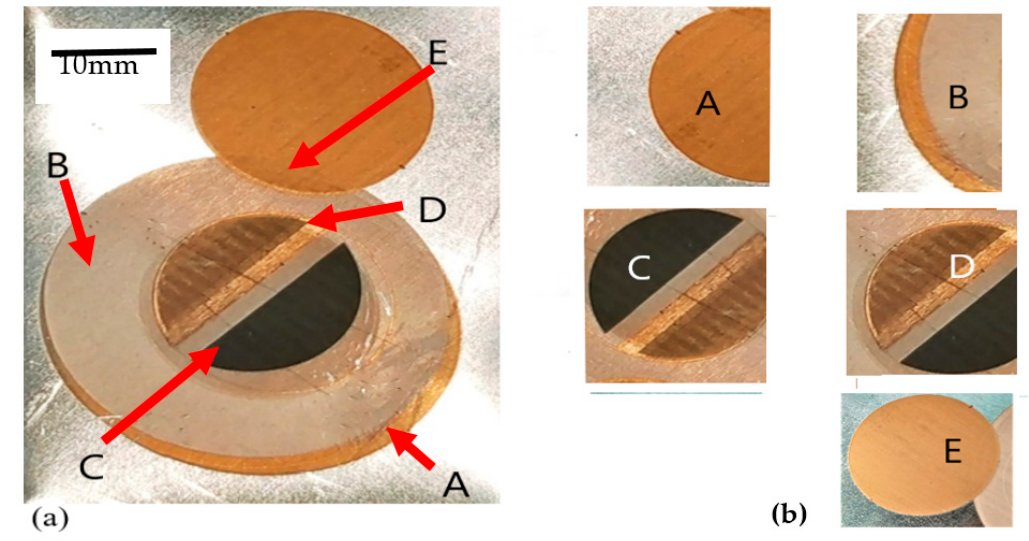
Figure 5. Demonstration of erasing the color from the treated sample and formation of new colors produced on the erased surface of aluminum. Panel ( a ): original sample; panel ( b ): explanation of panel ( a ): A , initially created dark golden disk. B , whitish color after erasing dark golden color, C , black semi-circle after erasing whitish color, D , light golden strip after erasing whitish color, and E , dark golden color painted on the whitish color. The scanning speeds for dark golden, white, black, and light golden were 70 mm / s, 1500 mm / s, 10 mm / s, 200 mm / s (two runs) respectively. The fluence of the laser beam was in the range 0.5–1.0 J / cm 2 . Figure 5b represents the images of A, B, C, D and E parts repectivly. In the center of the circle a strip was colored to light golden (D), and finally, part of the whitish surface of the same sample was colored to dark golden (E). Such manipulation of colors demonstrates the reproducibility and sustainability of these samples. The erasing and alteration of colors were achieved by changing the fluence of the laser beam by varying the position of the sample from the focus position (0.5 J / cm 2 to 1.0 J / cm 2 ). The surface was restored to each previous color by irradiating at a smaller fluence with regard to the initial coloring procedure by changing the processed sample position with respect to the focal plane of F-Theta lens and ablating the existing patterns. In that case, the number of pulses on the surface area and the resulting incident fluence were governed by the scanning speed for each color at 150 kHz repetition rate. The slower speed (i.e; below 70 mm / s) resulted in an excessive absorbed energy and a rather roughly treated surface due to its ablation, whereas